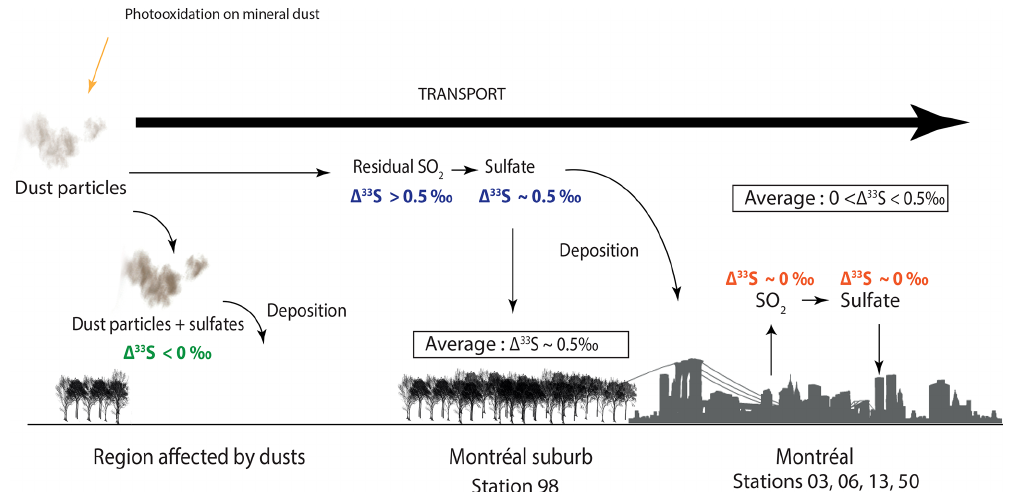
Figure 6. Scheme of the reaction mechanisms leading to the formation of sulfates driven by airborne mineral dust. The 33 S-enriched residual SO 2 is supposedly transported to cities, while the 33 S-depleted sulfates are deposited along with dust particles in the rural